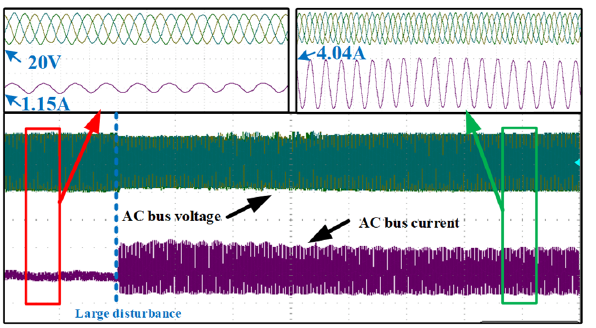
Figure 19. The curves of AC bus voltages and currents in discharging state (Group A).